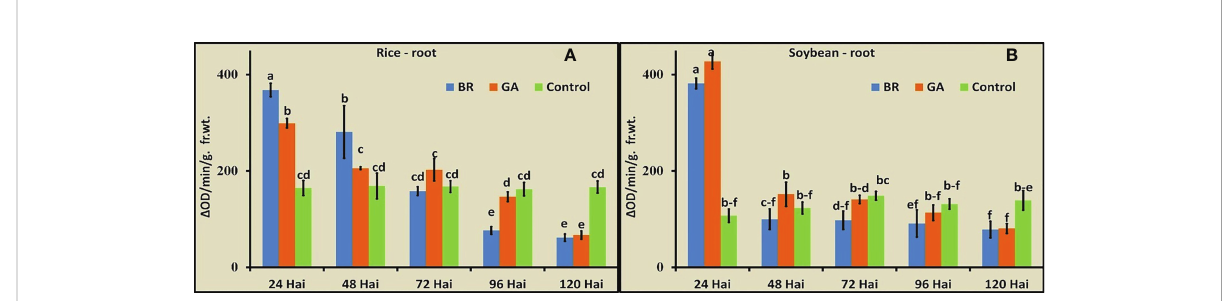
FIGURE 4 Peroxidase activity at the fi ve time points after inoculation with Gluconacetobacter diazotrophicus (GAB) and Bradyrhizobium japonicum (BRH). (A) Rice root, (B) soybean root. Small letter on the top of the bar indicates the critical differences. Same letters indicate statistically non- signi fi cant and different letters indicate statistically signi fi